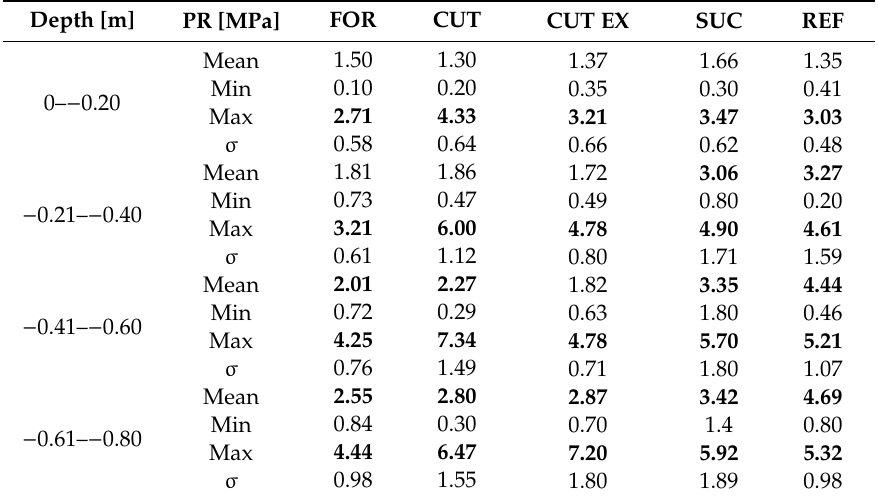
Figure 9. Penetration resistance (PR) dataset distribution. Dotted lines (2, 3 MPa) represent literature-based, critical PR affecting root growth according to [13]. Table 7. Descriptive statistics (mean, minimum, maximum, standard deviation ( σ )) for penetration resistance (PR), depth aggregated data. Values > 2 MPa indicated bold.